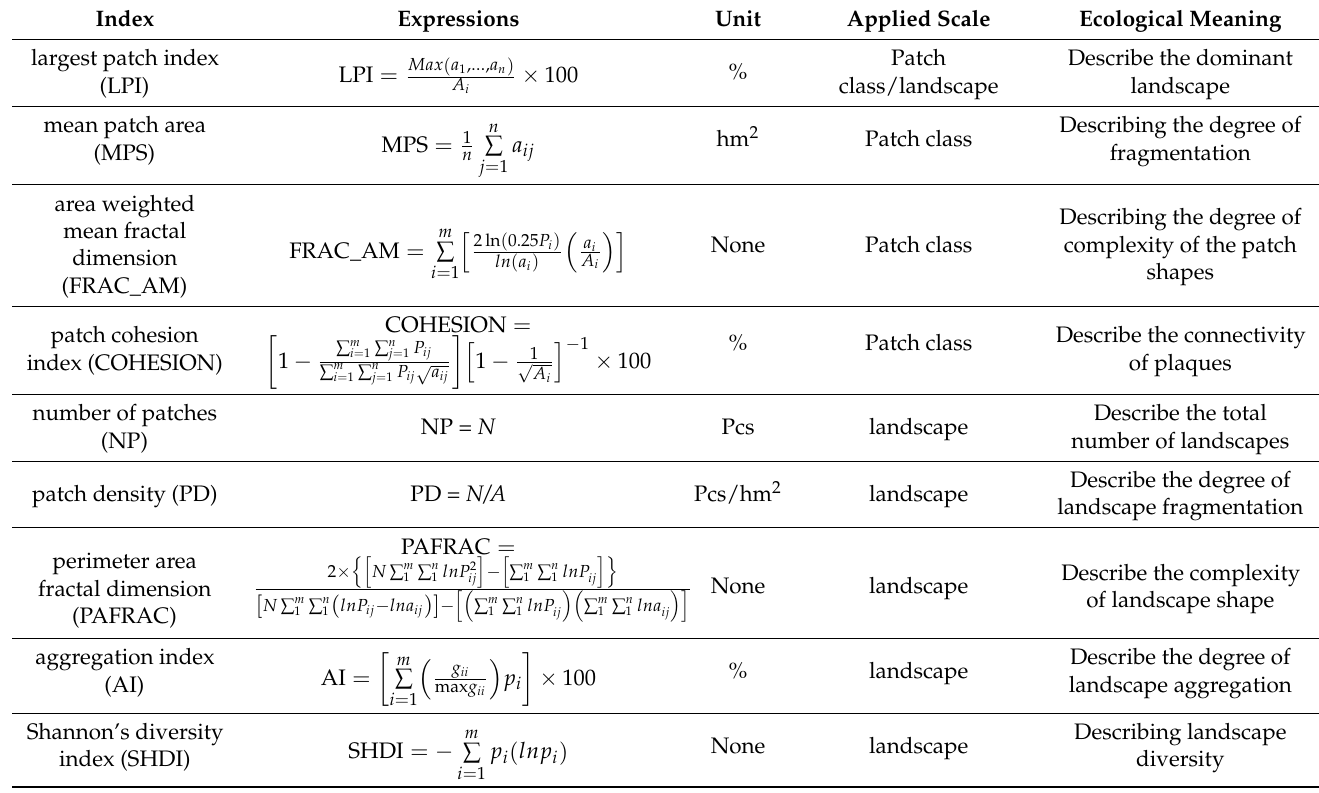
Table 2. Indexes used in the study and their ecological meaning in the landscape pattern.